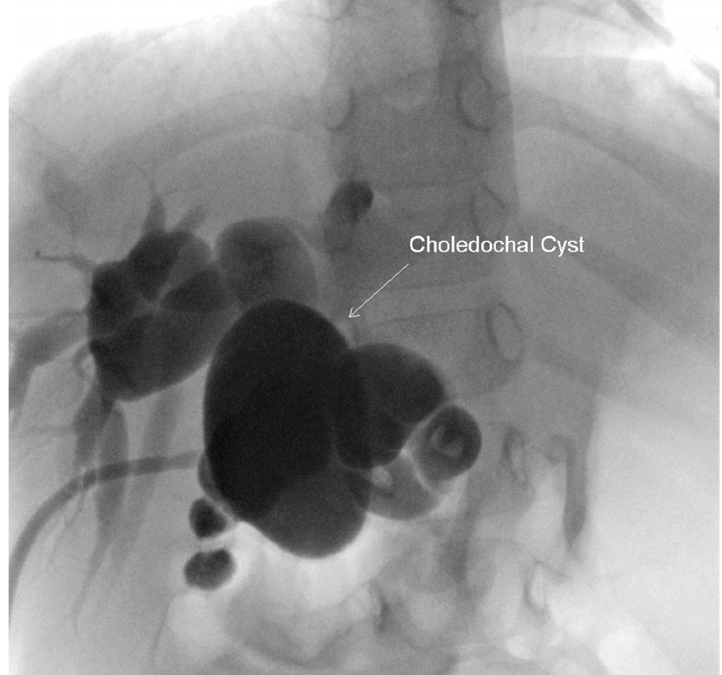
Figure 4. Intra-operative cholangiogram performed at two years of age, demonstrating a persistently dilated biliary tree with a revisualization of the choledochal cyst approximately 59 × 37